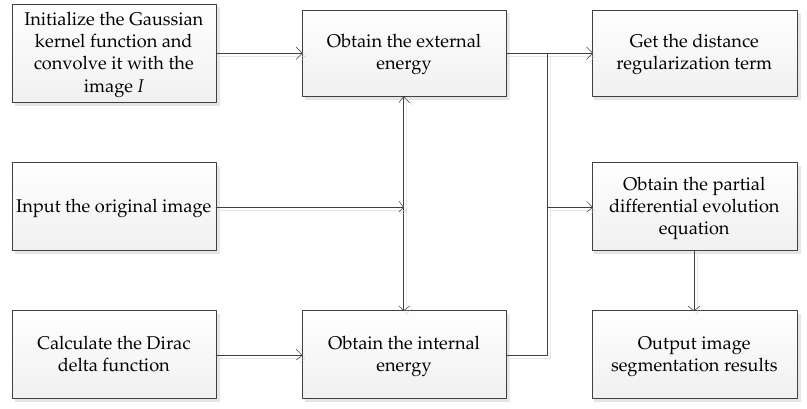
Figure Figure 1. The process of the proposed improved regularized level set-based image segmentation method. After the abovementioned procedures of image segmentation, the detailed steps of the proposed IRLS-IS method can be summarized as follows.